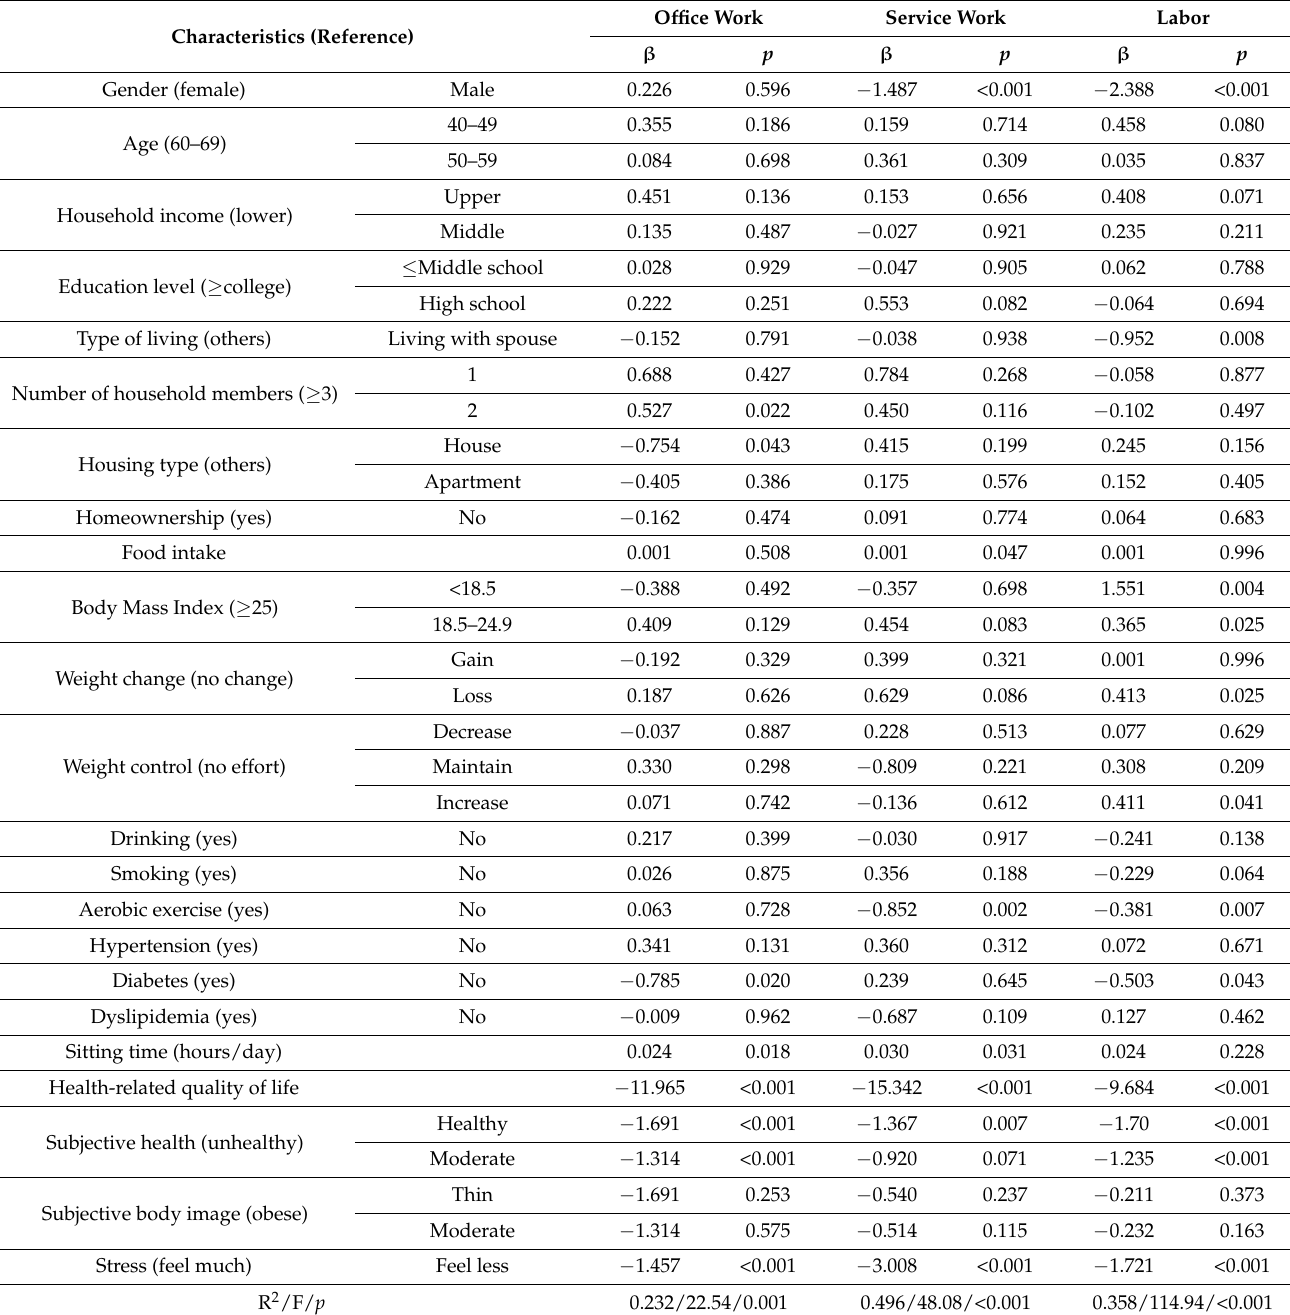
Table 3. Factors influencing depressive symptoms by job type by complex sample linear regression analysis (N =